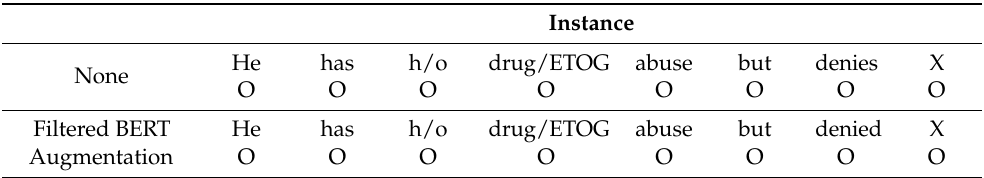
Table 2. Examples of instances created as a result of filtered augmentation.